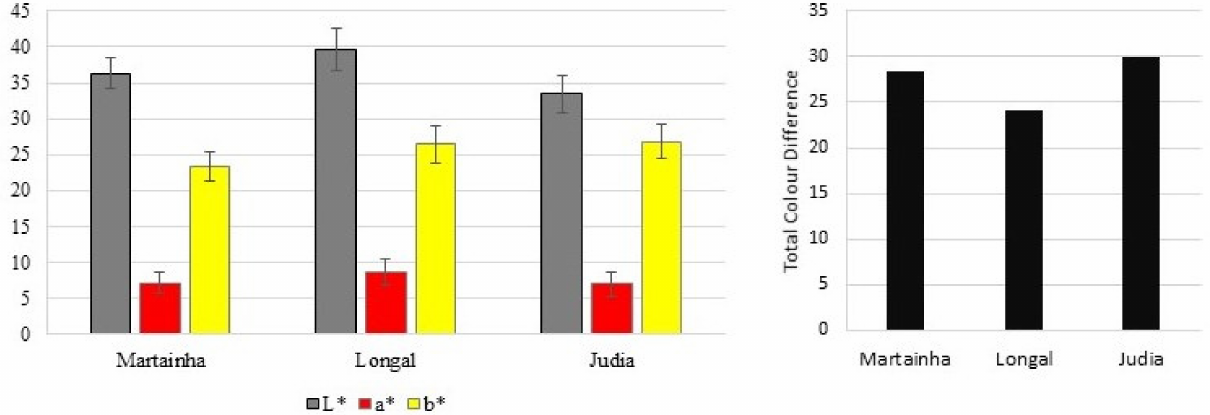
Figure 8. Colour coordinates for the three candied chestnuts ( left ) and total colour difference having the fresh fruits as reference ( right